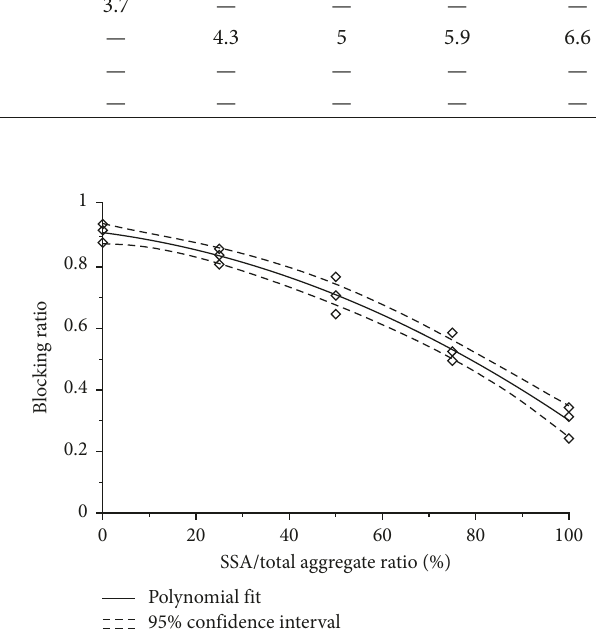
Figure 7: Relationship between the SSA replacement ratio and the blocking ratio.